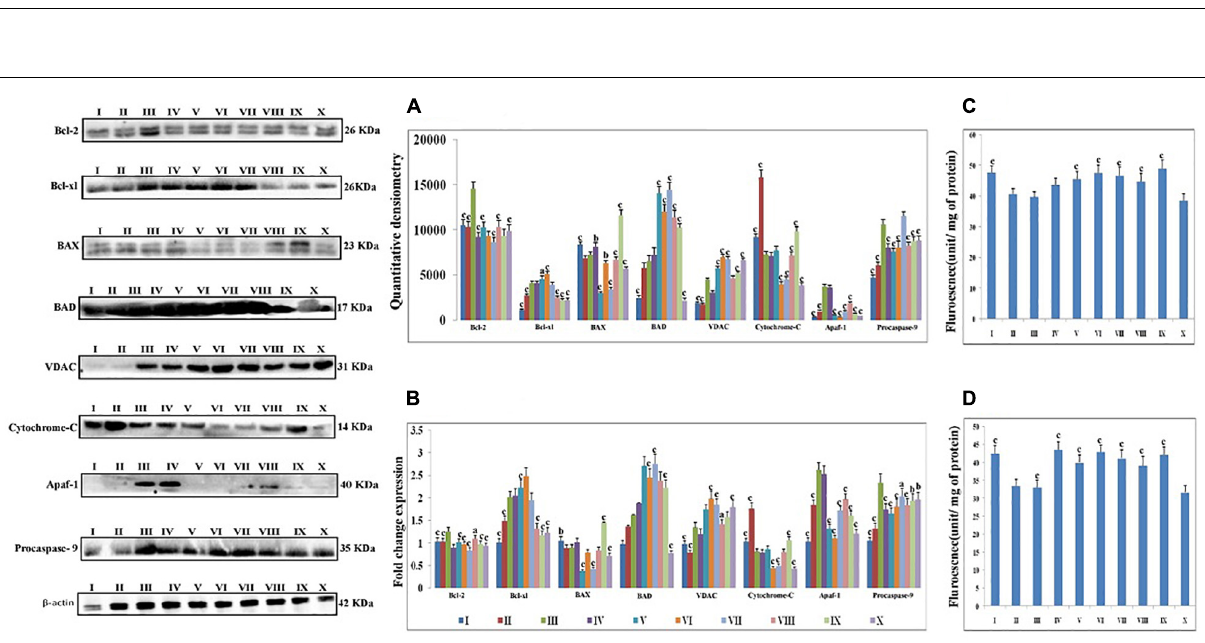
Frontiers in Pharmacology |